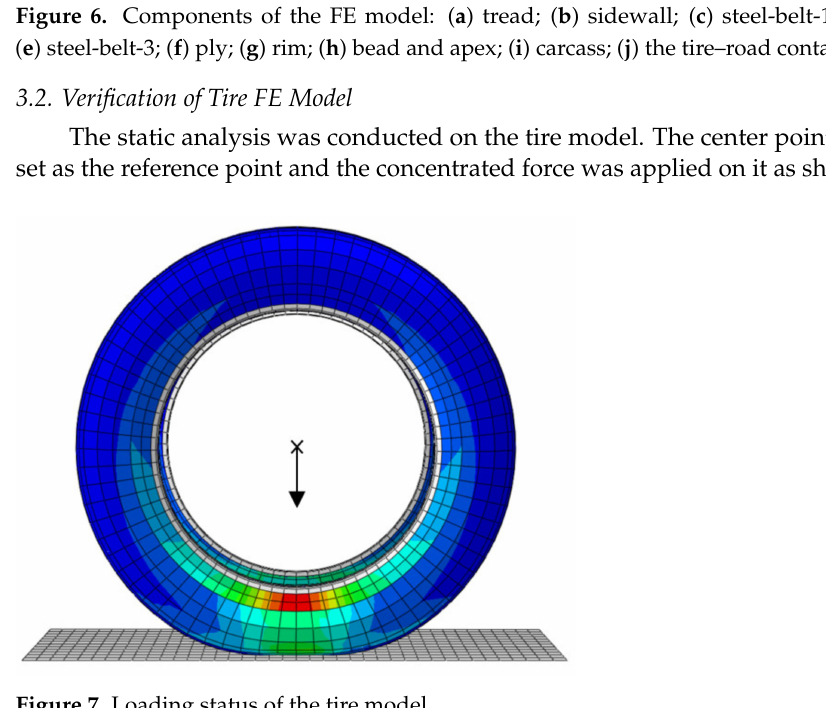
Figure 7. Loading status of the tire